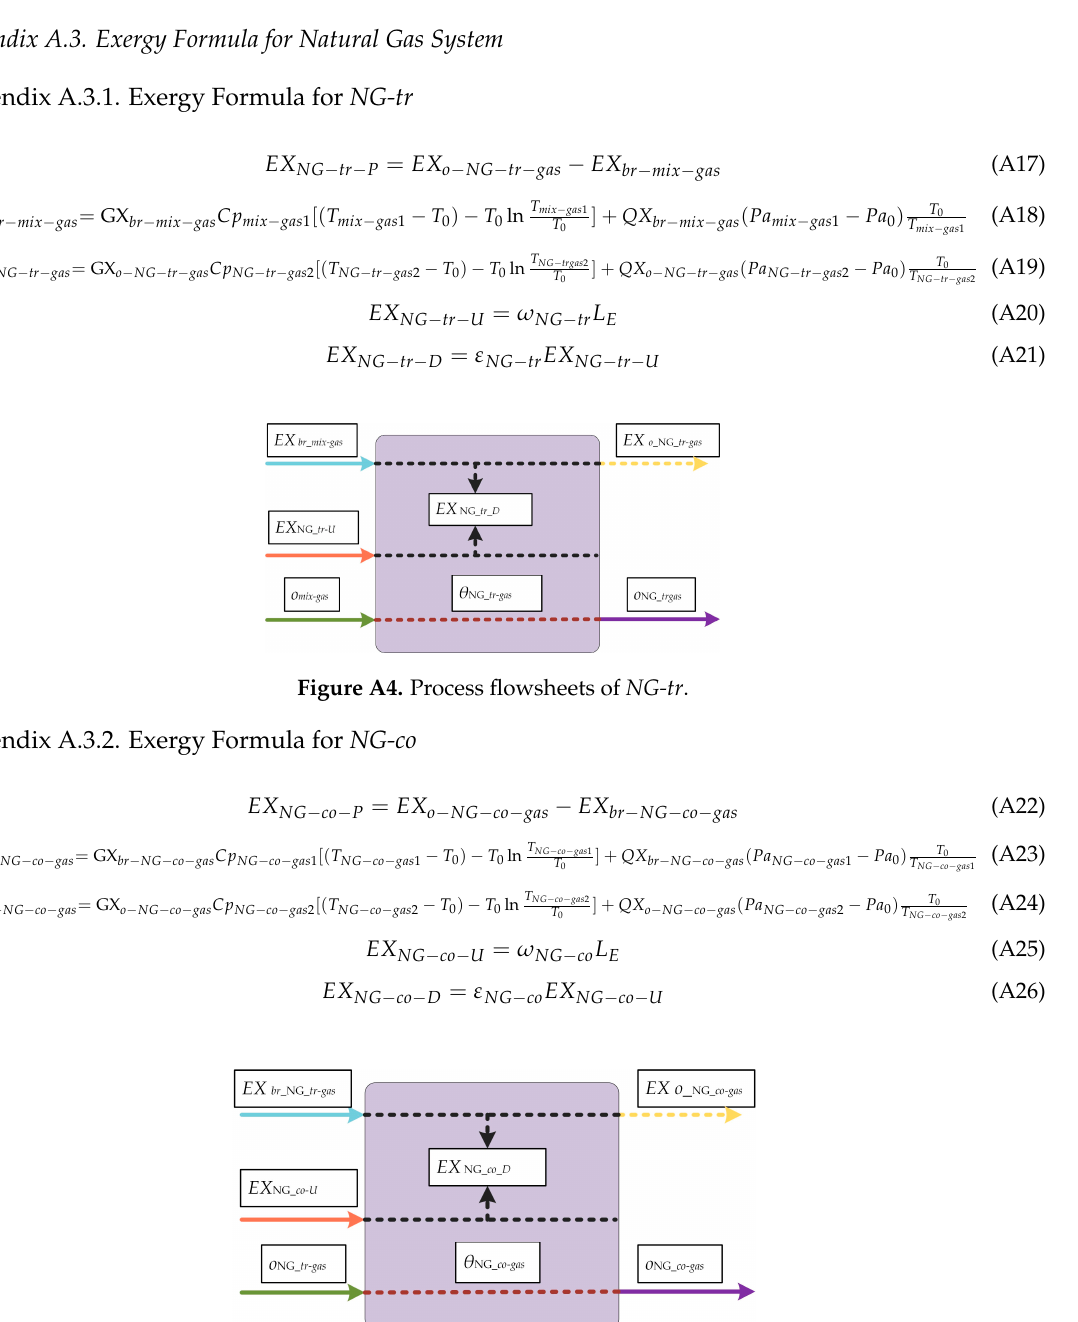
Figure A3. Process flowsheets of CR-oil .